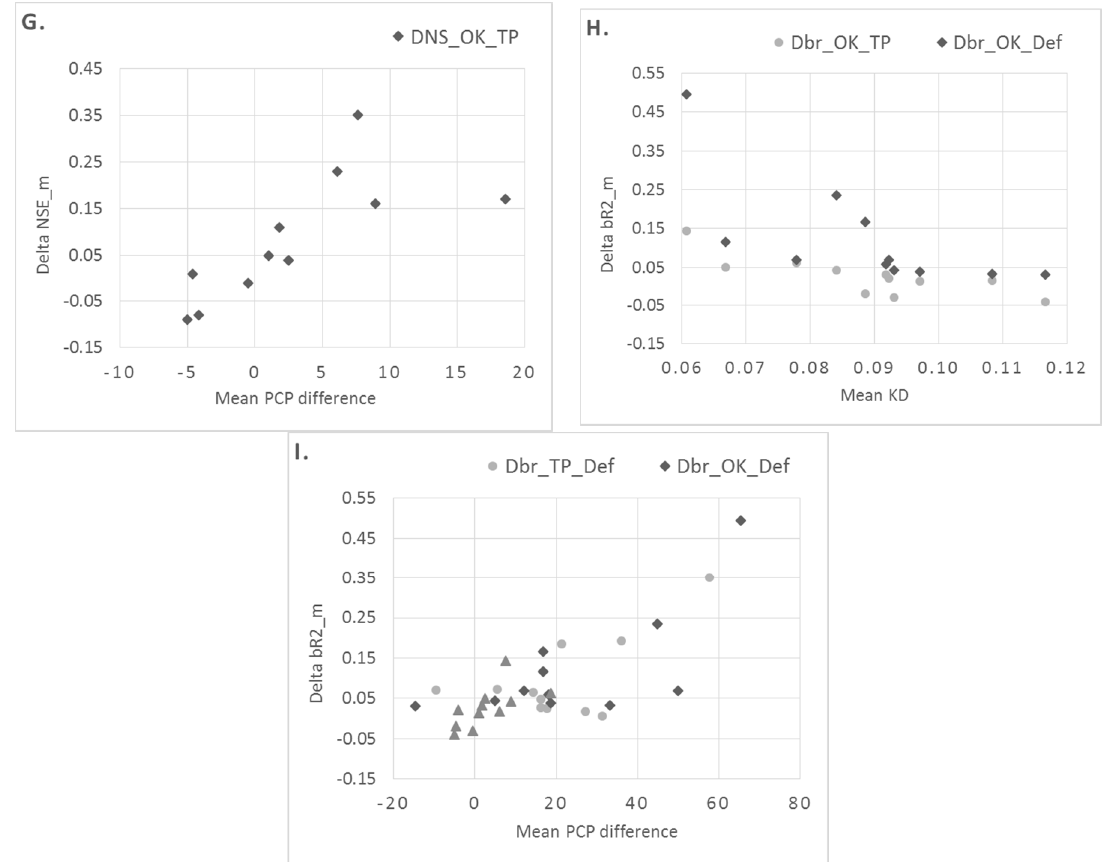
Figure 10. Scatter plots of ∆(cid:1841)(cid:1832) and various catchment descriptors for relationships with (cid:3025),(cid:3026),(cid:3047) significant correlation (at significance level (cid:1868) = 0.05) from Table 3. Note: DNS_X_Y = , Dbr_X_Y = ∆(cid:1854)(cid:1844) (cid:3025),(cid:3026)(cid:2870) ∆(cid:1840)(cid:1845) (cid:3025),(cid:3026)